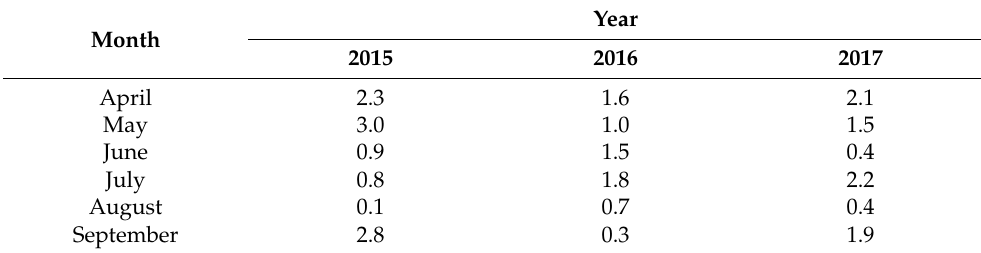
Figure 3. Distribution of average air temperatures and precipitation against the long-term average (1989–2014) according to the Agrometeorological Station in Uhnin. Table 4. Values of the Sielianinov hydrothermal coefficient (2015–2017).